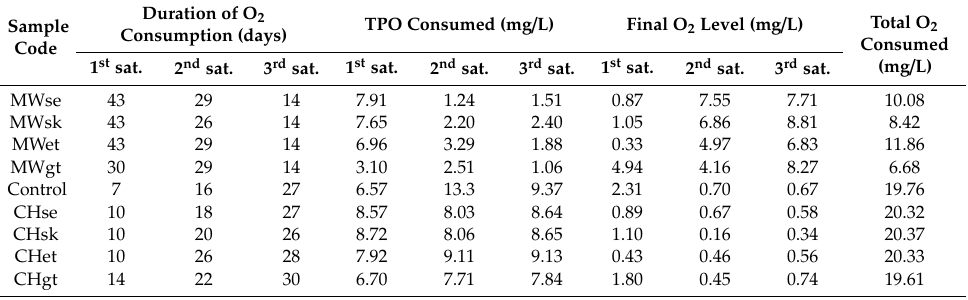
Table 1. Oxygen consumption parameters in model wines and Chianti red wines with tannins added. Codification of wines / tannins are detailed in Table